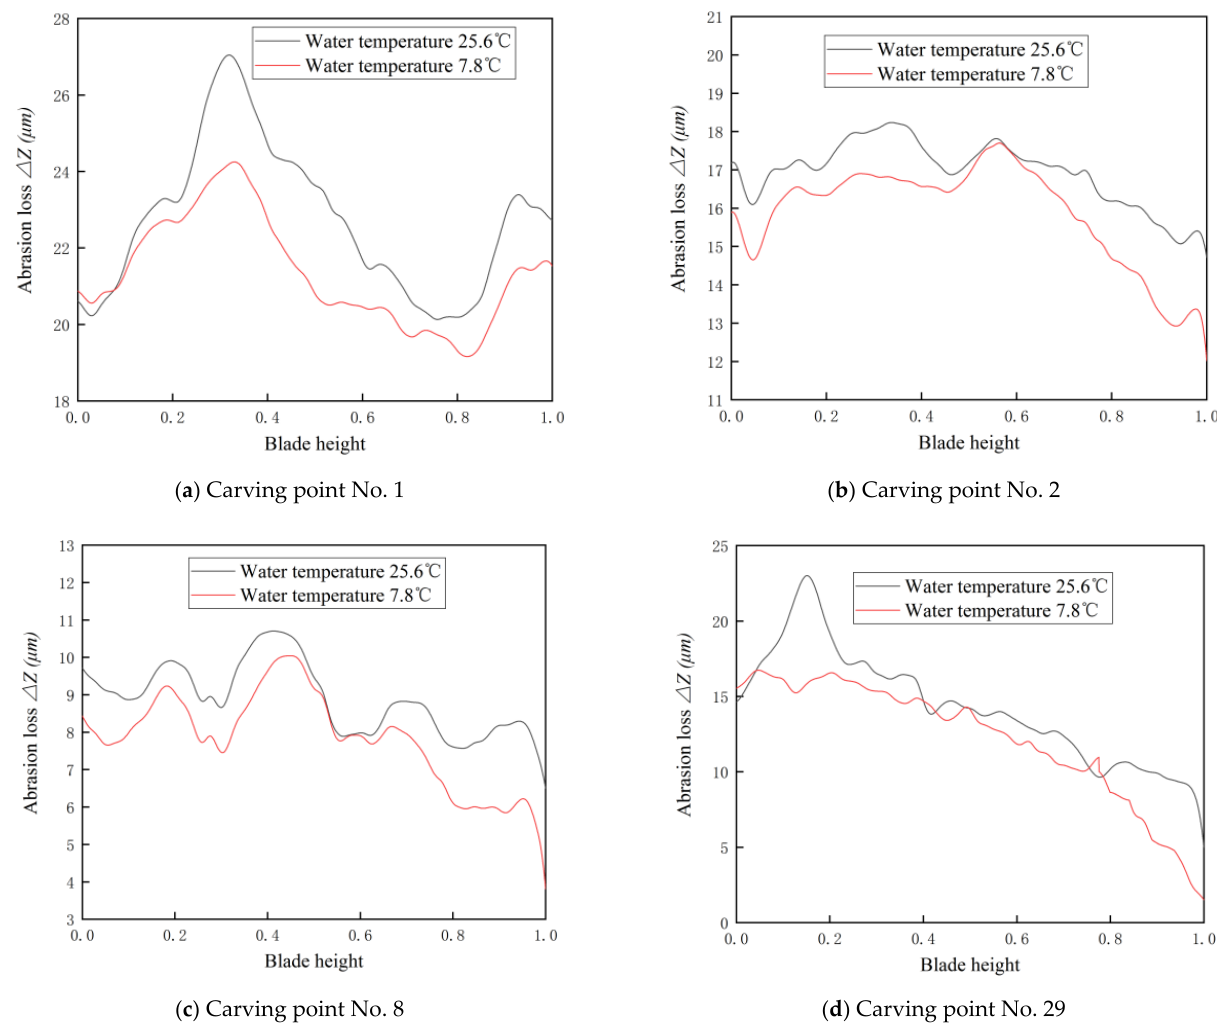
Figure 20. ( a – d ) Wear amount at different scoring points ( P = 30.9 MW).